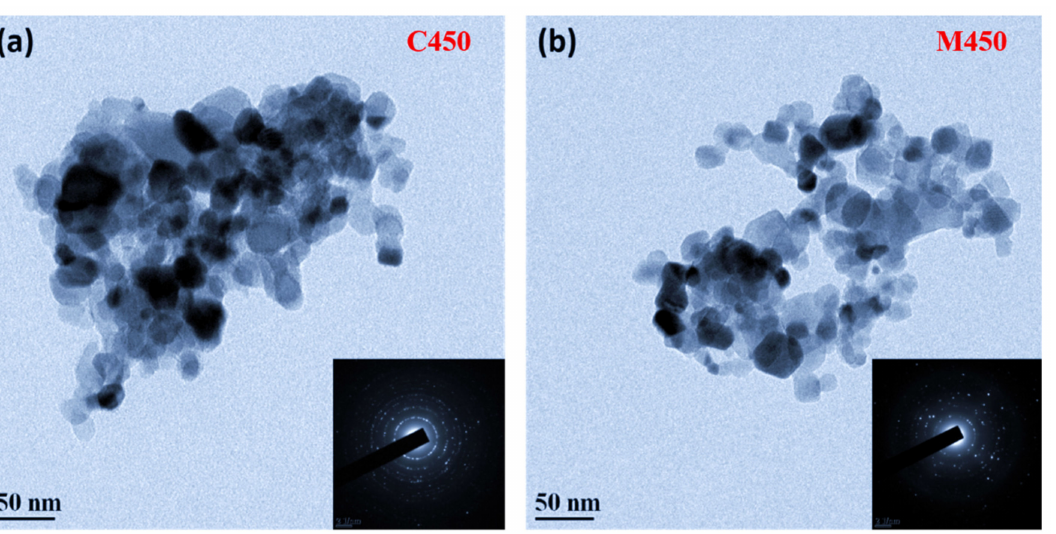
Figure 6. Transmission electron microscopy images of ( a ) Conventionally sintered titania, ( b ) Microwave sintered titania and their corresponding SAED patterns are in the inset.